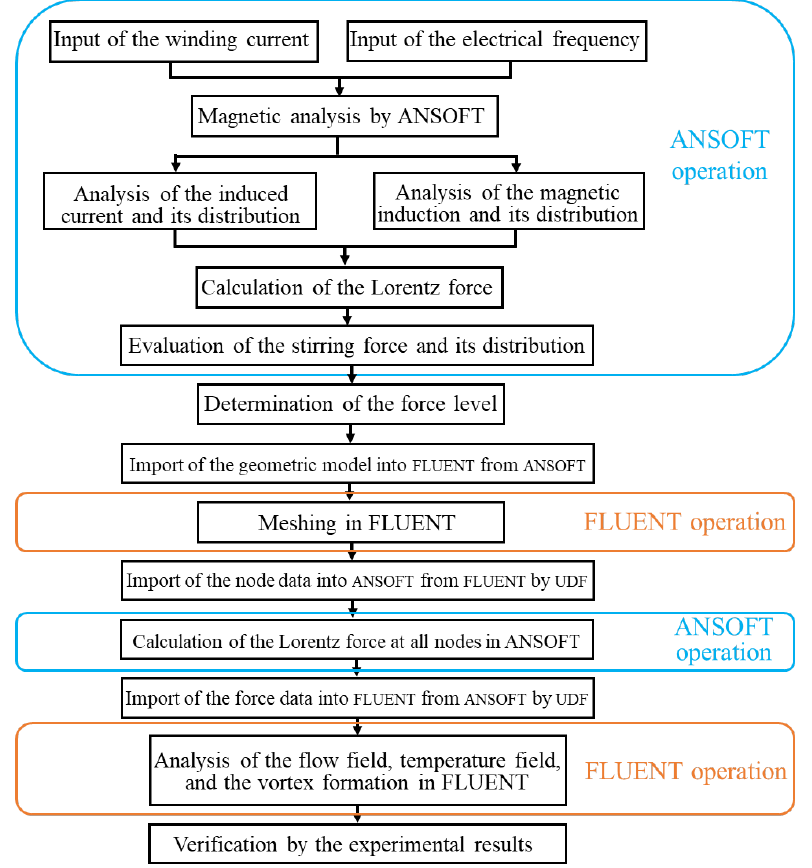
Figure 1. Research approach for magnetic-current-thermal multi-physics analysis.